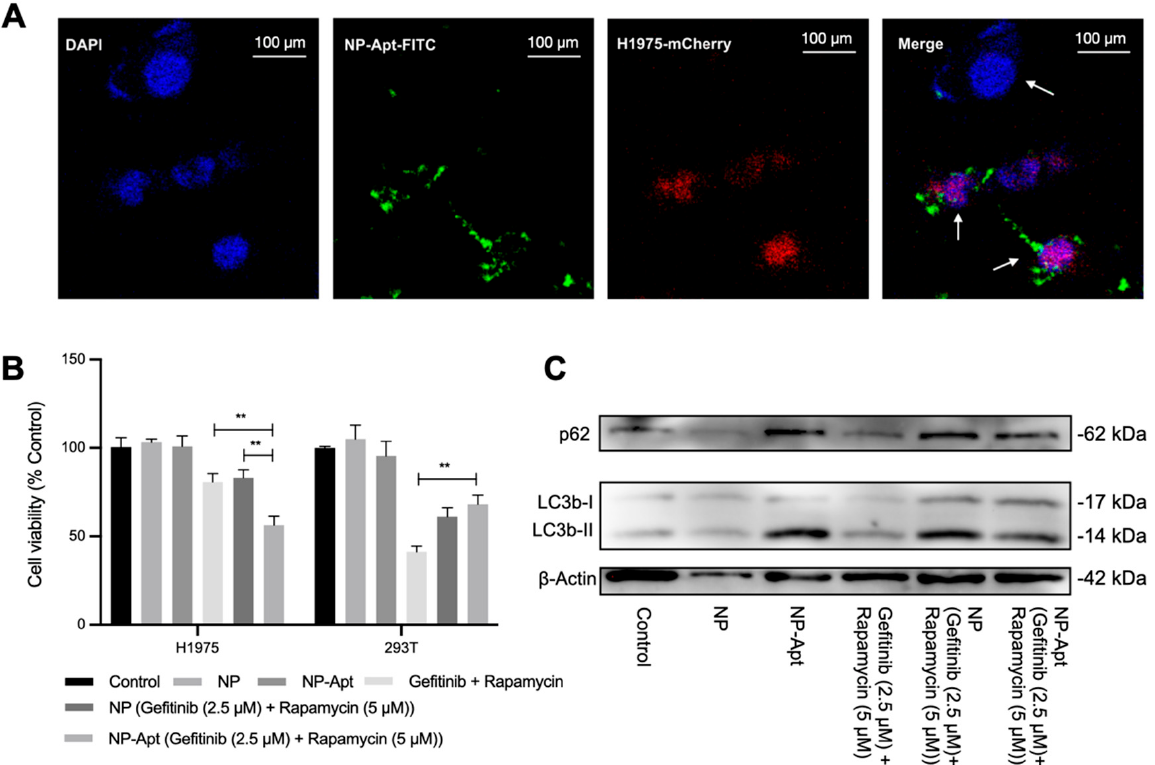
Figure 4. Target delivery and toxicity of NP − Apt (gefitinib + rapamycin). ( A ) Selective cell uptake of NP − Apt. H1975 cells 293T cells were co − cultured in one dish. H1975 cells displayed blue and red fluorescence due to the DAPI staining and mCherry transfection. The 293T cells displayed only blue fluorescence. NP − Apt were conjugated with FITC showing green fluorescence. White arrows indicate 293T and H1975 cells. ( B ) Cell viability assay 48 h of H1975 cells and 293T cells after various treatments: control (DMEM), NP, NP − Apt, gefitinib + rapamycin, NP (gefitinib + rapamycin), NP − Apt (gefitinib + rapamycin). The dosages of gefitinib and rapamycin were 2.5 and 5 µ M. All data are representative of at least three independent experiments. ** p < 0.01. ( C ) Immunoblotting analysis of p62 and LC3b protein expression in H1975 cells under different treatments.